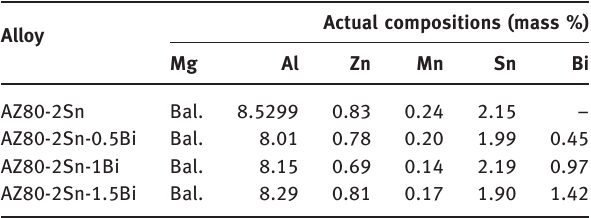
Table 1: Chemical compositions of AZ80-2Sn-xBi alloys.